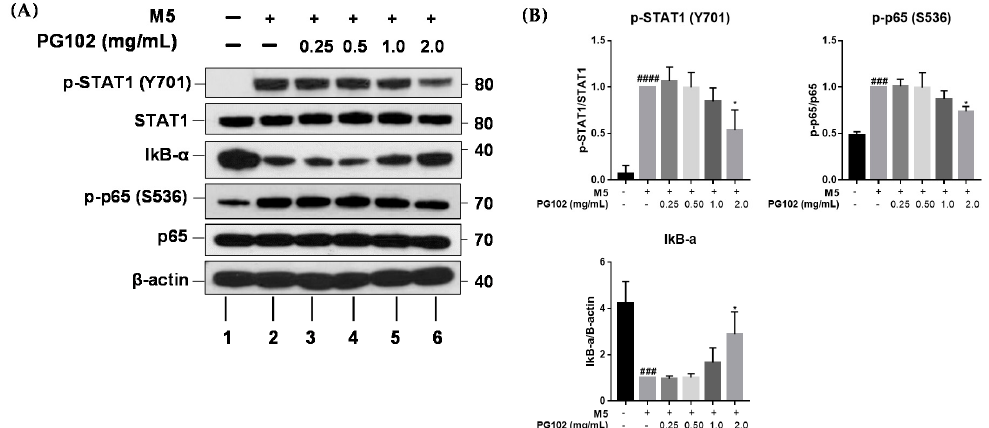
Figure 6. PG102 inhibits NF- κ B and STAT1 signaling in HaCaT cells. ( A ) Western blot results of corresponding proteins after treatment with M5 and PG102 for 30 min. ( B ) Densitometry of Western blot. The means of three experiments are shown. ### p < 0.001, #### p < 0.0001 versus Control group; * p < 0.05 versus M5-only treated group.